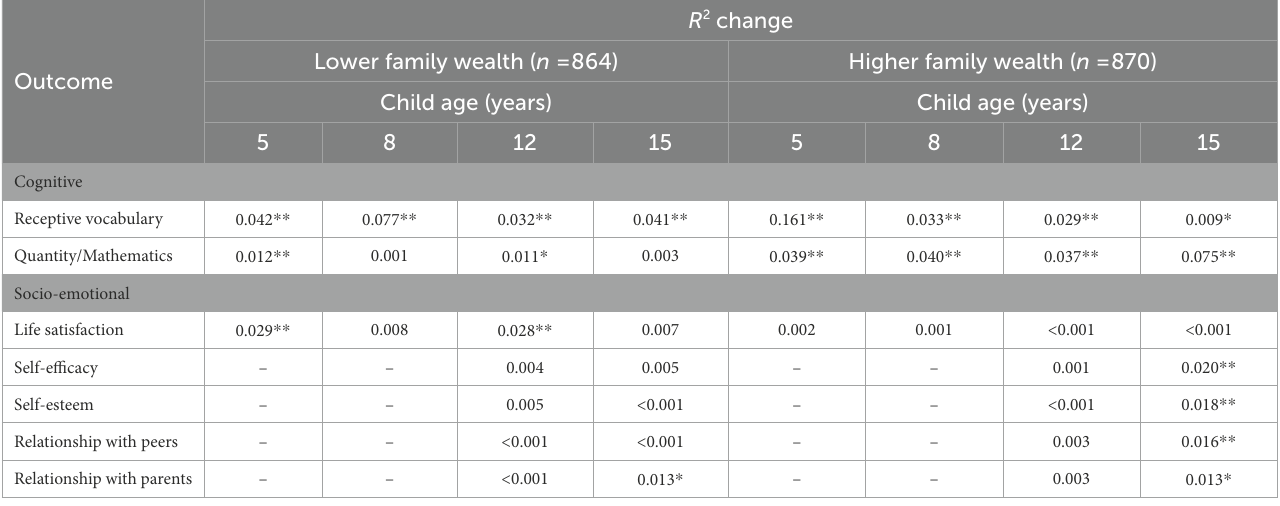
TABLE 8 Associations between the dose of preschool education received by Vietnamese children from poorer and wealthier^ families and their cognitive and socio-emotional outcomes at four ages after controlling for individual differences in child age.